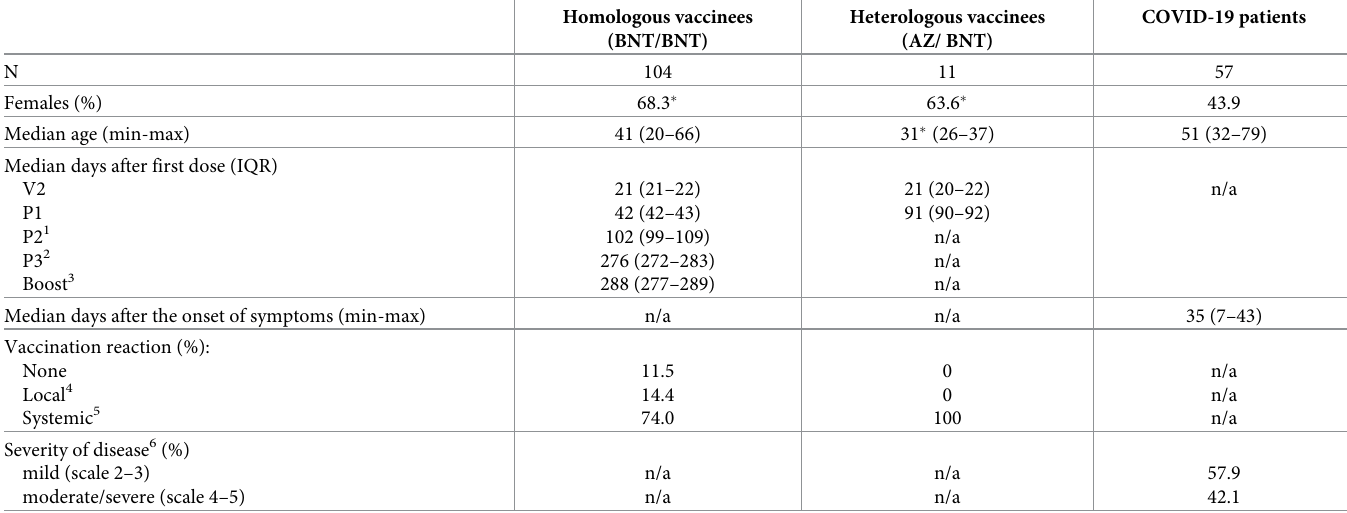
Table 1. Demographic characteristics of vaccinees and COVID-19